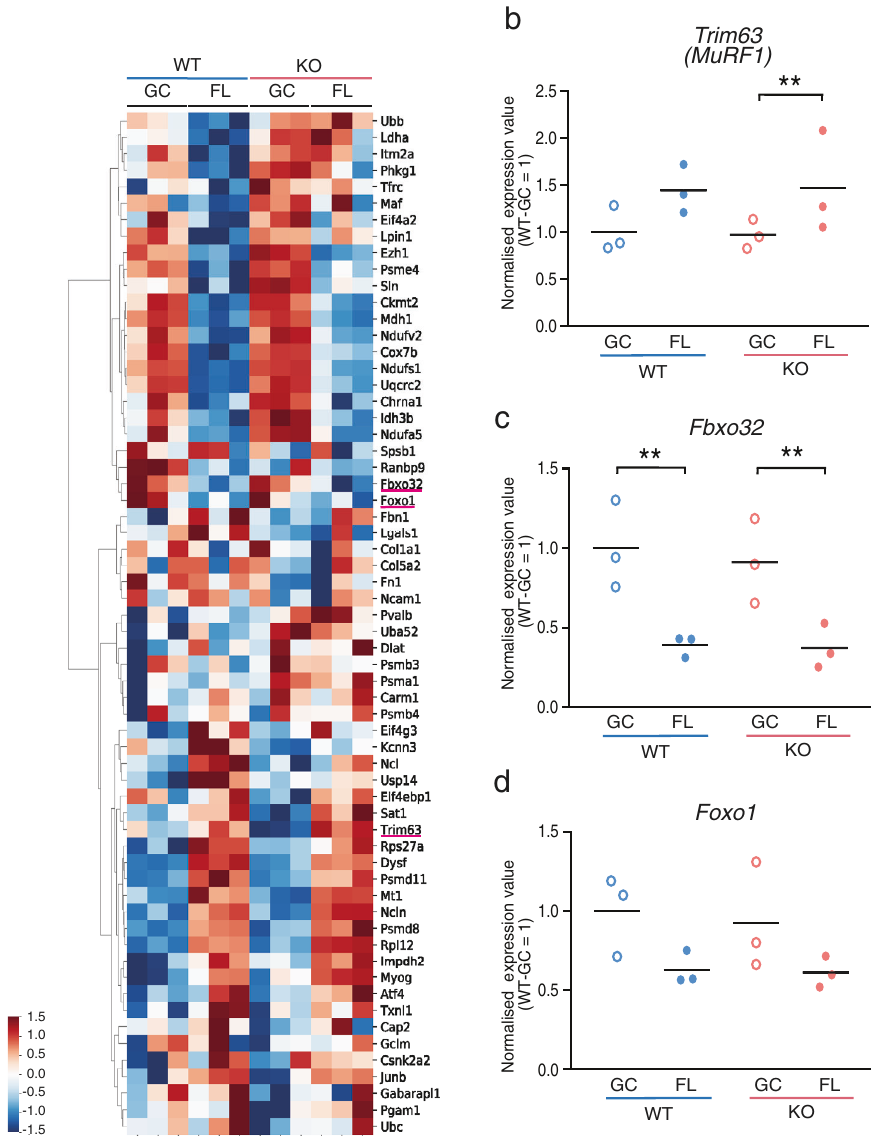
Fig. 3 Atrogene expression in space experiment. a Heatmap of atrogene expression values in soleus muscles from WT-GC, WT-FL, KO-GC and KO-FL mice. Expression values of Trim63 ( MuRF1 ) ( b ), Fbxo32 ( c ) and Foxo1 ( d ) genes in soleus muscles. Data are presented as mean, and each point represents individual mice. n = 3 for WT-GC, WT-FL, KO-GC and KO-FL. edgeR test ** P < 0.01